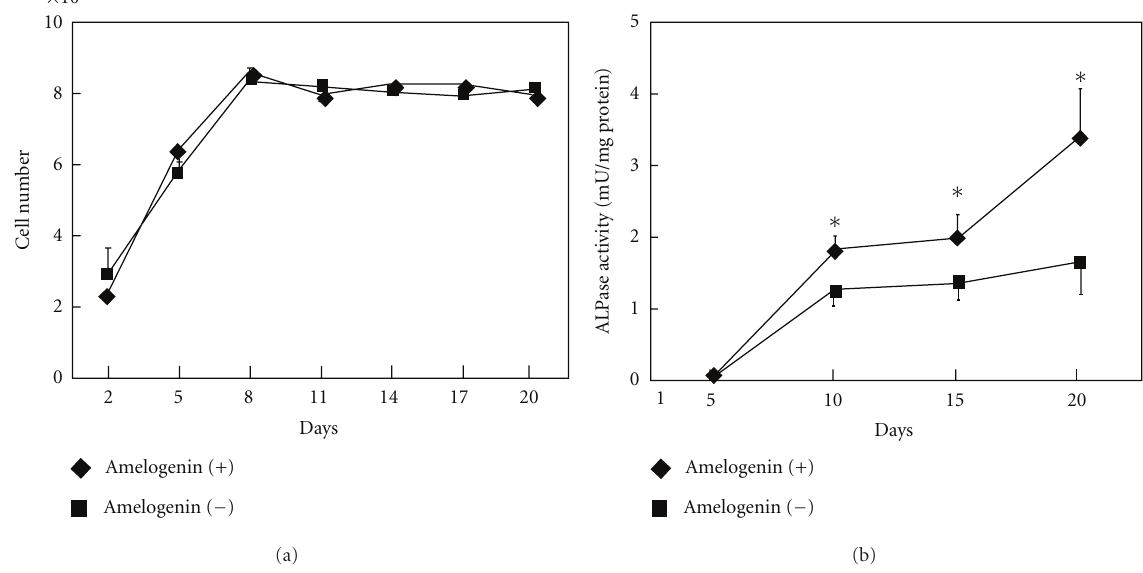
Figure 2: E ff ects of 100 ng/mL of amelogenin on proliferation and di ff erentiation of at bone marrow mesenchymal stem cells. (a) Time- course changes in numbers of cells cultured with and without amelogenin. (b) Time-course changes in ALPase activity of cells cultured with and without amelogenin. Data represent means ± SD in three samples in three separate experiments. Significantly di ff erent from control values ( ∗ P < 0 .